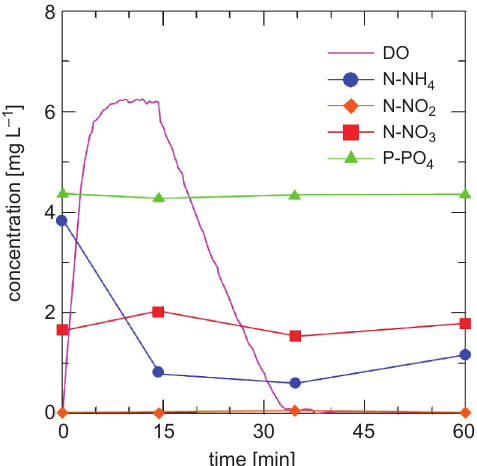
Fig. 3 – Oxygen, ammonium, nitrite, nitrate, and phosphorus concentration profiles in the IACMB. Operating cycle 30–30, t = 30 min, t = 30 aer mix